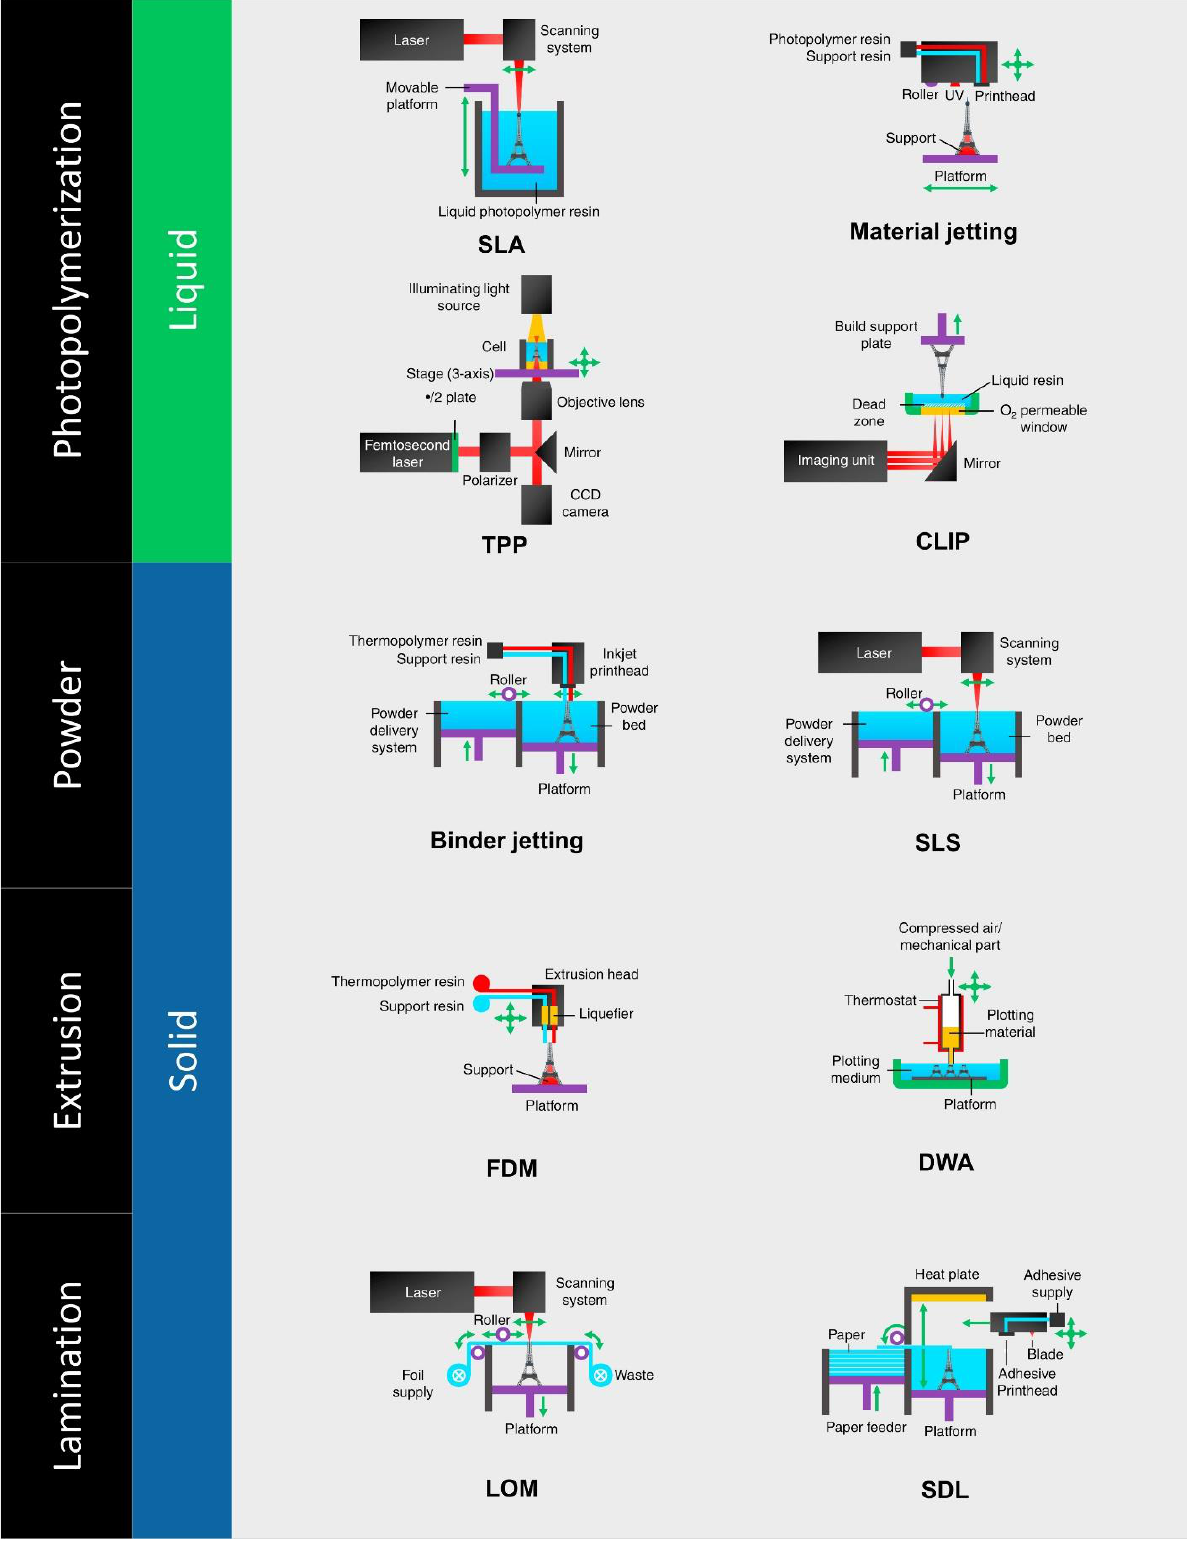
Figure 7. A summary of the major 3D printing organisations and technologies. Stereolithography (SLA), two-photon polymerisation (TPP), continuous liquid interface production (CLIP), fused deposition modelling (FDM), direct writing assembly (DWA) (DWA could be used in both liquid and